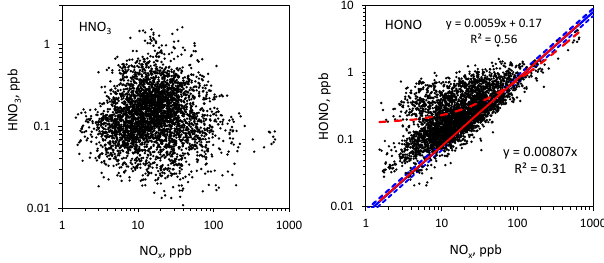
Fig. 10. Nitric and nitrous acid as a function of NO x . The blue lines in the right panel are the HONO-to-NO x ratios 0.008 ± 0.001 by Kurtenbach et al. (2001), the red continuous line the regression line that was done by forcing the offset to zero and the red dashed line without forcing the